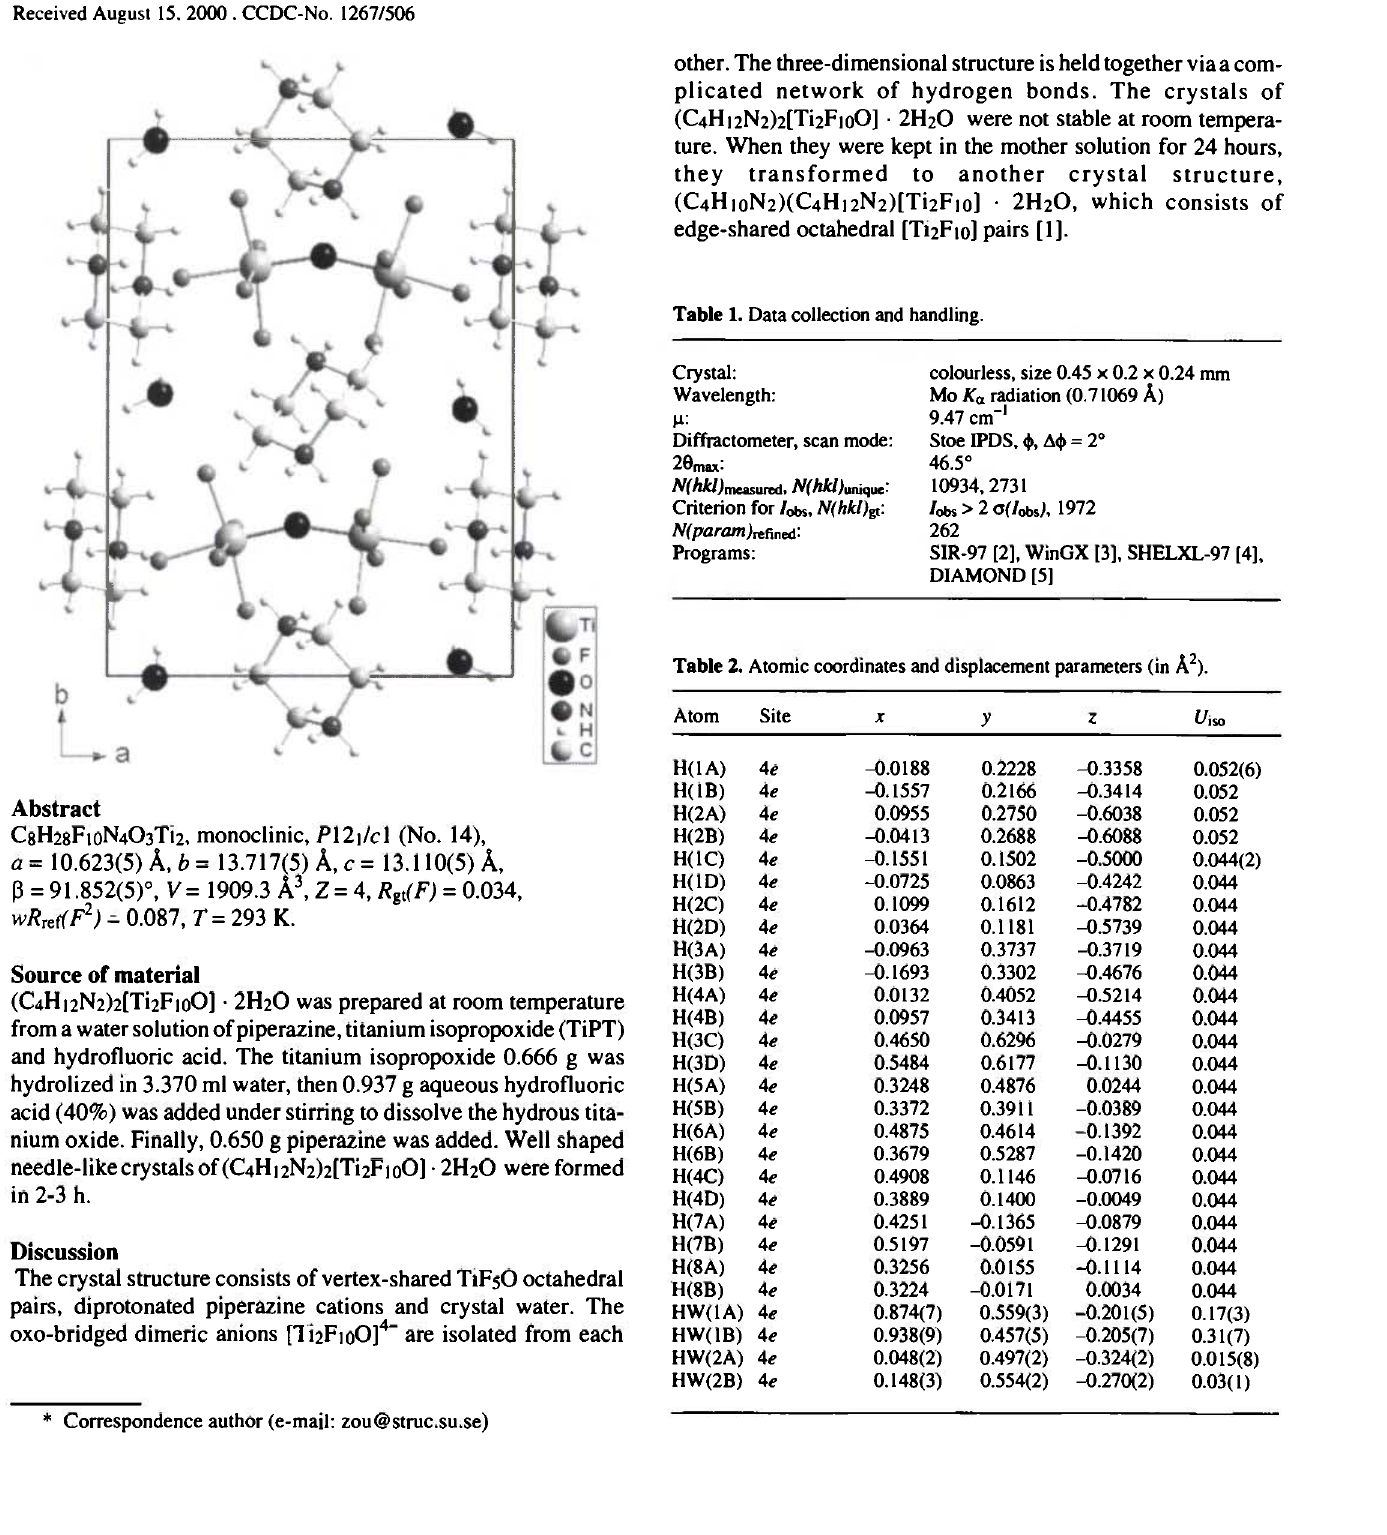
Table 1. Data collection and handling.